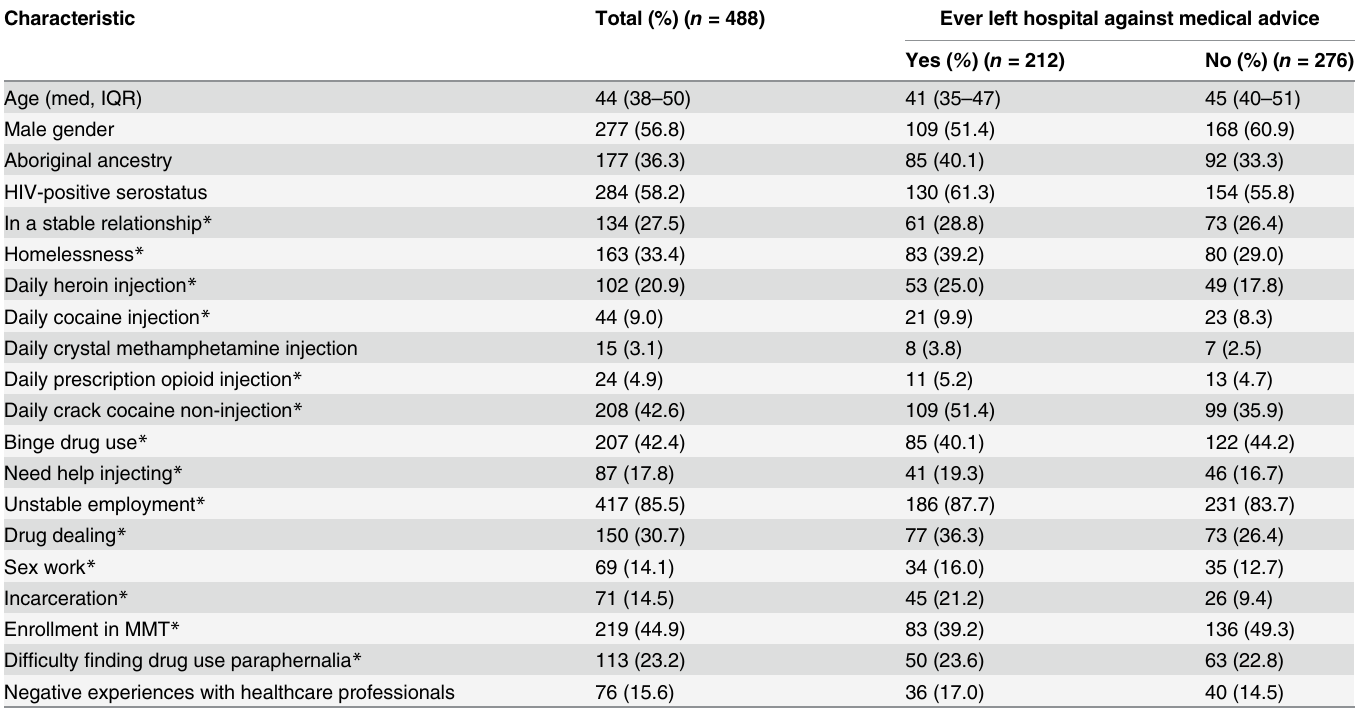
Table 1. Sample characteristics stratified by having ever left hospital against medical advice (n =